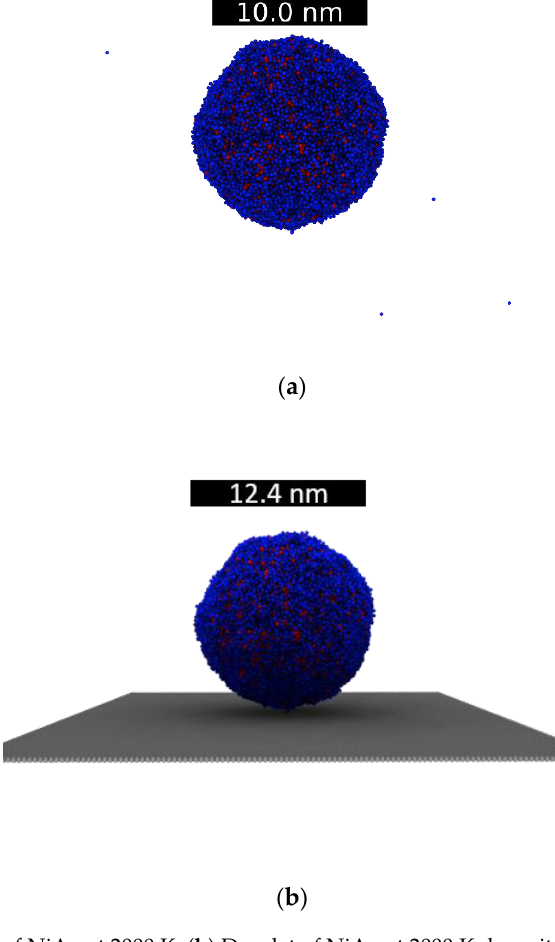
Figure 3. ( a ) Droplet of NiAg at 2000 K. ( b ) Droplet of NiAg at 2000 K deposited on 1-layer of graphite. The scale bar on ( b ) corresponds to the diameter of the droplet. Color code: Ni, red and Ag, blue.